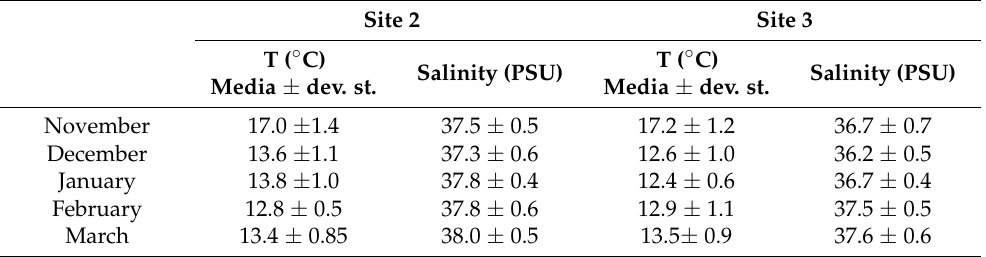
Table 1. Physiochemical parameters of seawater measured during oysters’ relaying period at sites 2 and